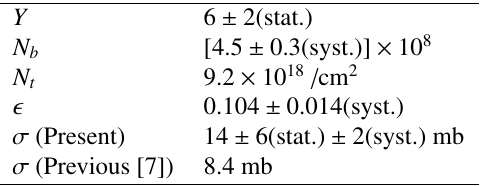
Table 1. Summary of the experimental